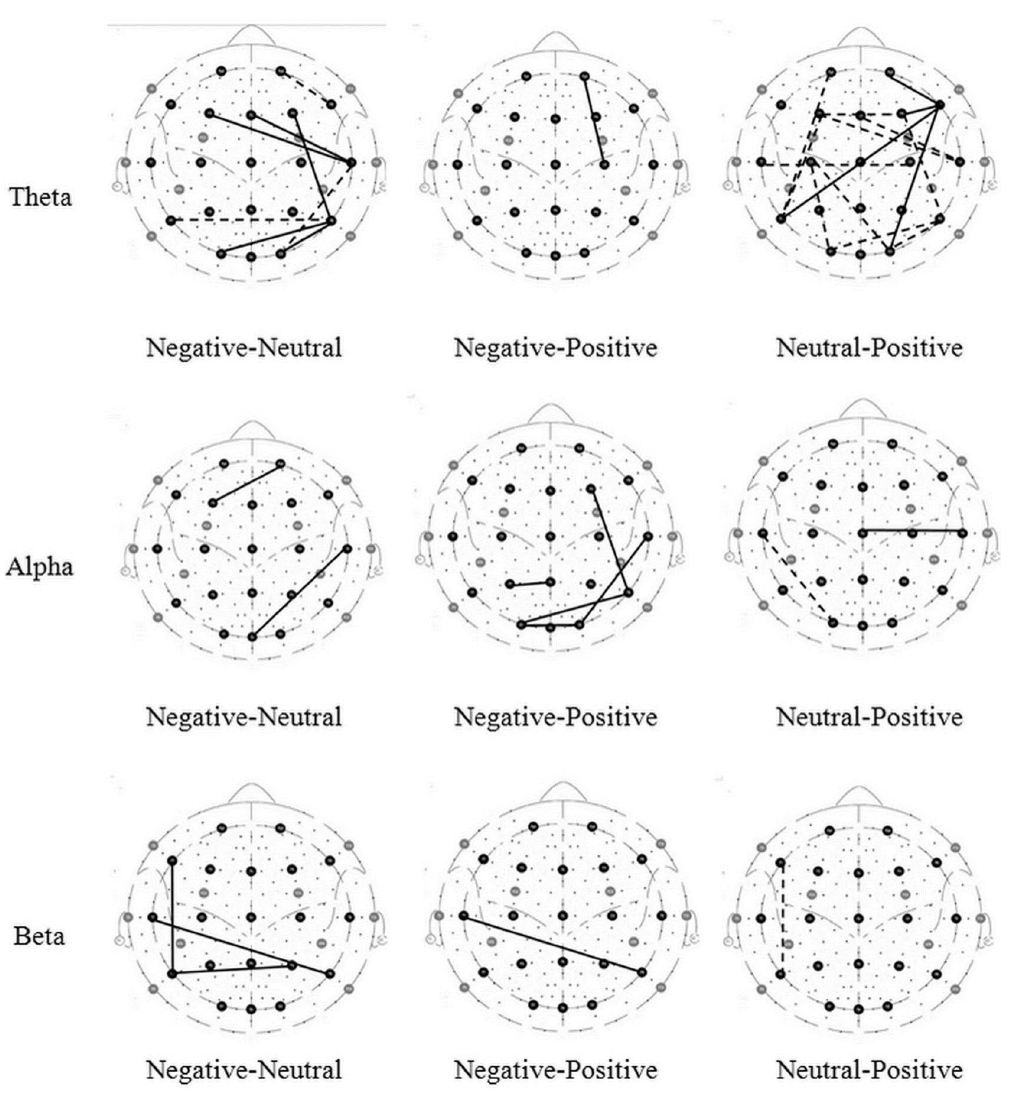
Figure 2. Brain maps of coherence. The lines connecting electrode sites indicate significant higher (solid) and lower (dashed) of coherence values for condition listed on left site.